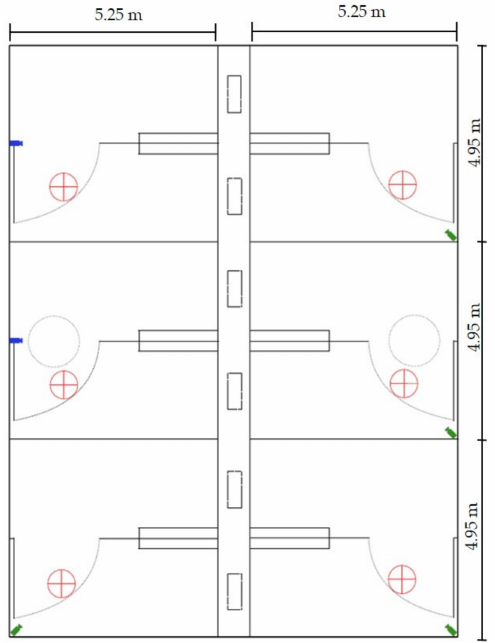
Figure 2. Compartment on a commercial fattening farm with identical fully slatted pens on each side of a central corridor. Pens are divisible by a turnable wall (radius depicted by dotted line). Cameras (Sony ® , EuroTech ® ) were fixed to the ceiling. exhaust air fan, inlet air flap, sensor-equipped feeding trough, rooting